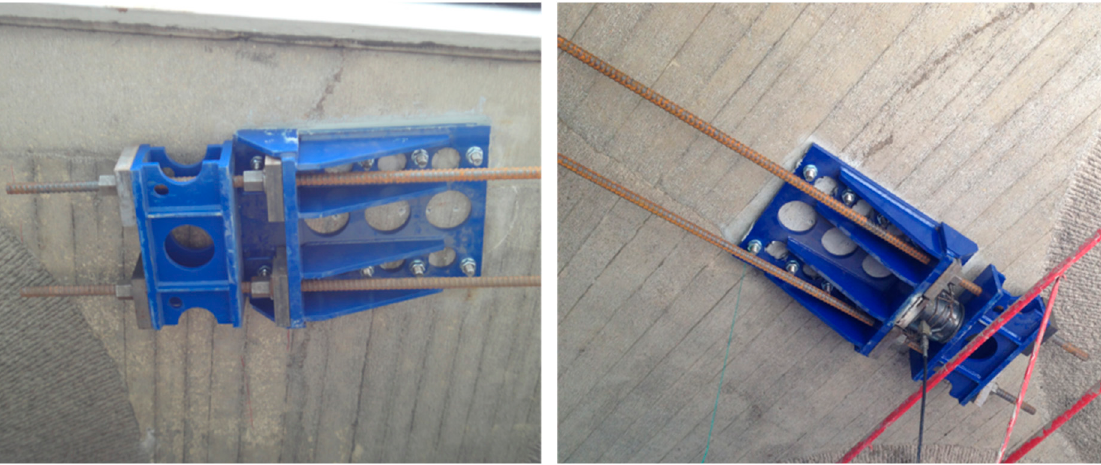
Figure 22. Passive ( left ) and active ( right ) anchorages.